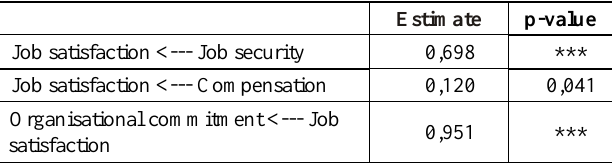
Table 6: Parameter estimates and p-values